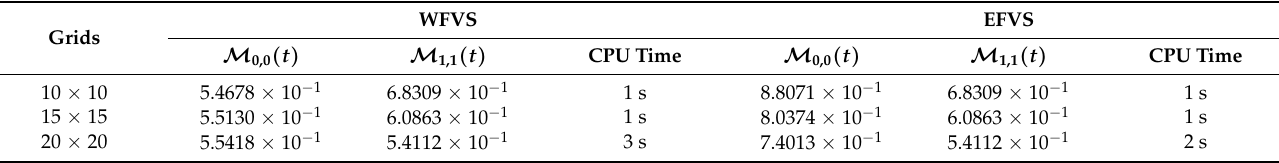
Figure 6. Comparison of different moments with selection function S = xy , and breakage functions b 3 , b 4 . Table 10. Relative error for the weighted moments at different grid points for the test case with S = xy and breakage function b 3 at t =